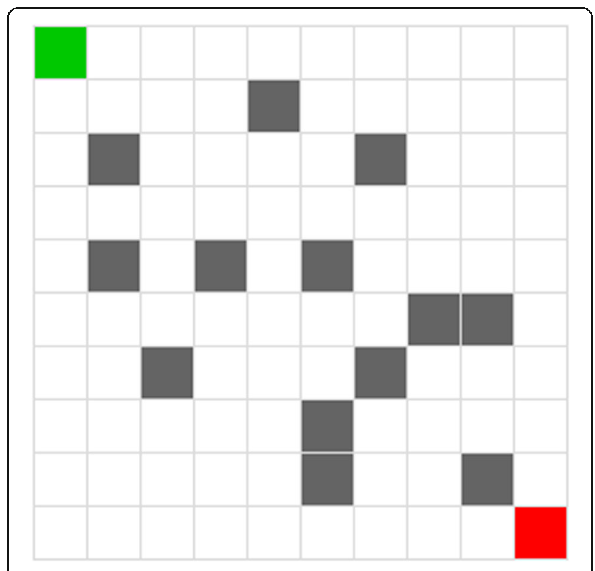
Fig. 1 Grid method to establish environment model. Figure illustrates that the unmanned work space is decomposed into a series of binary information grid cells